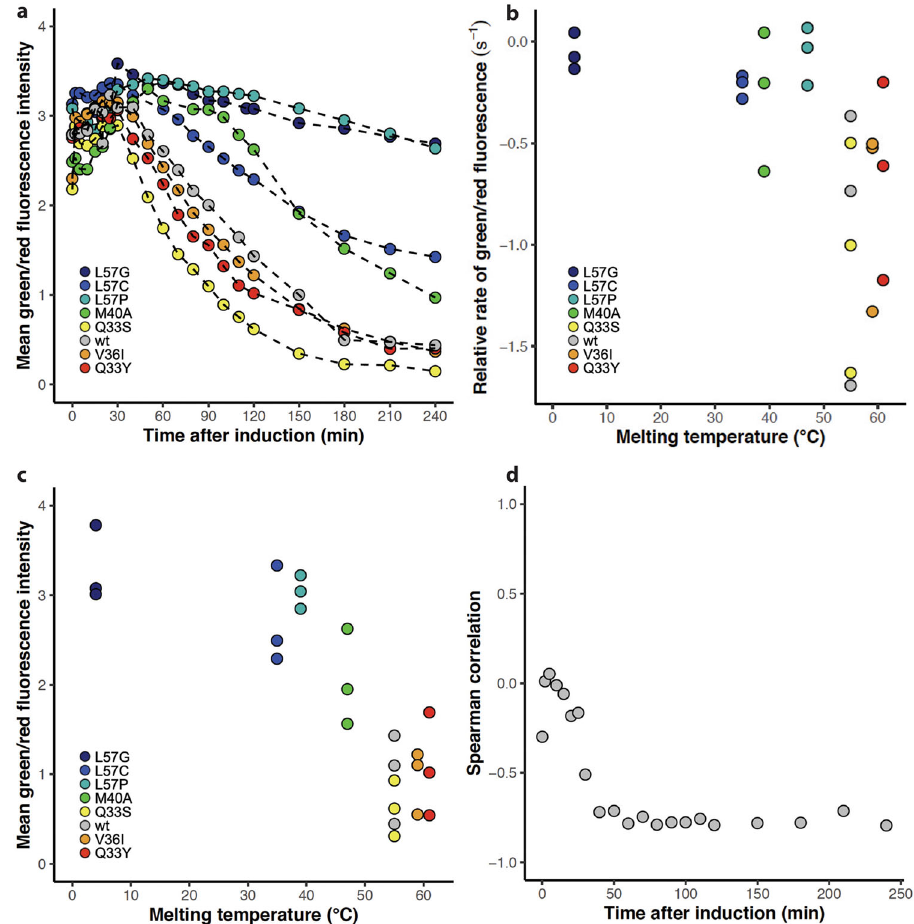
Fig. 5 Accumulated transcription from the DnaK promoter normalised to protein abundance. a Mean green fl uorescence intensity divided by red fl uorescence intensity of cells expressing variants: L57G (dark blue), L57C (blue), L57P (cyan), M40A (green), Q33S (yellow), V36I (orange), Q33Y (red) and wt (grey). One of three replicates is shown for each variant. b Relative rate of green/red fl uorescence (30 – 60 min) as a function of melting temperature. Spearman correlation = − 0.63). Colour scheme as in ( a ). c Mean green fl uorescence intensity divided by red fl uorescence intensity at the 120 min time point for the eight N102LT variants with different melting temperatures. Spearman correlation between green/red fl uorescence intensity and variant melting temperature is − 0.79. Colour scheme as in ( a ). d Spearman correlation between green/red fl uorescence intensity and variant melting temperature at each time point. Calculations are based on three replicates of each